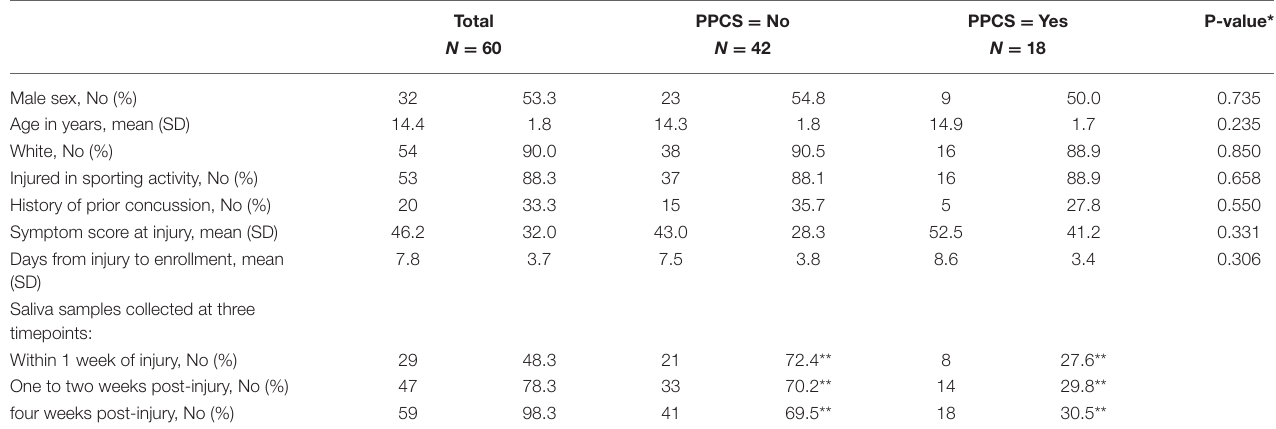
TABLE 1 | Demographic characteristics of study participants ( N = 60